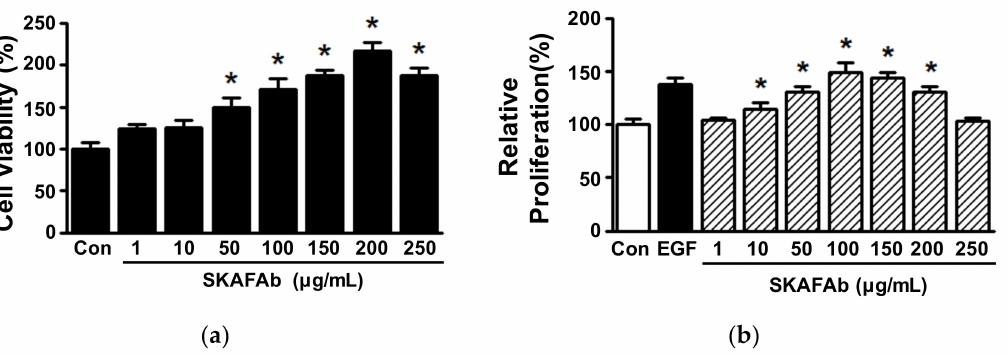
Figure 2. Effects of Salix koreensis Anderss flower absolute on keratinocyte viability and proliferation. ( a ) HaCaT cells were incubated in the presence or absence of Salix koreensis Anderss flower absolute (SKAFAb; 1–250 µ g/mL) for 36 h. Cell viabilities were analyzed using a WST assay ( n = 5). ( b ) HaCaT cells were treated with SKAFAb (1–250 µ g/mL) for 36 h. Cell proliferations were assessed using a BrdU incorporation assay ( n = 5). Recombinant human epidermal growth factor (rhEGF: 50 ng/mL) was used as a positive control. Percentages are of levels versus untreated cells (Con). Results are presented as means ± standard errors of means (SEMs). p -values by one-way analysis of variance